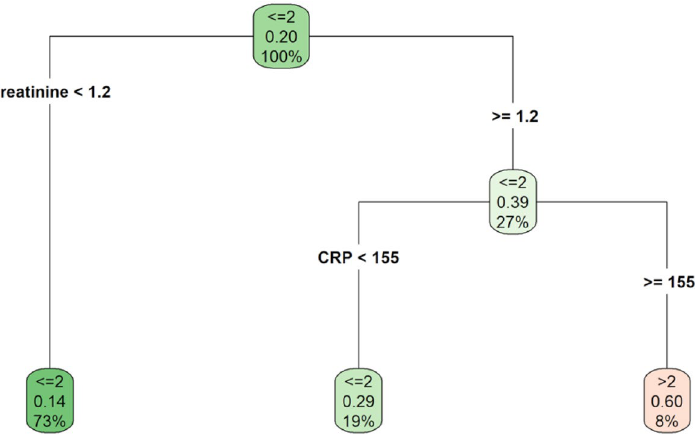
Figure 2. Classification regression tree. Outcome: SOFA > 2; covariates: age, sex, BMI, CRP, creatinine, CAD, diabetes, COPD, NPL, MBP, AKI, HYP and the reduction of anti-hypertensive therapy during